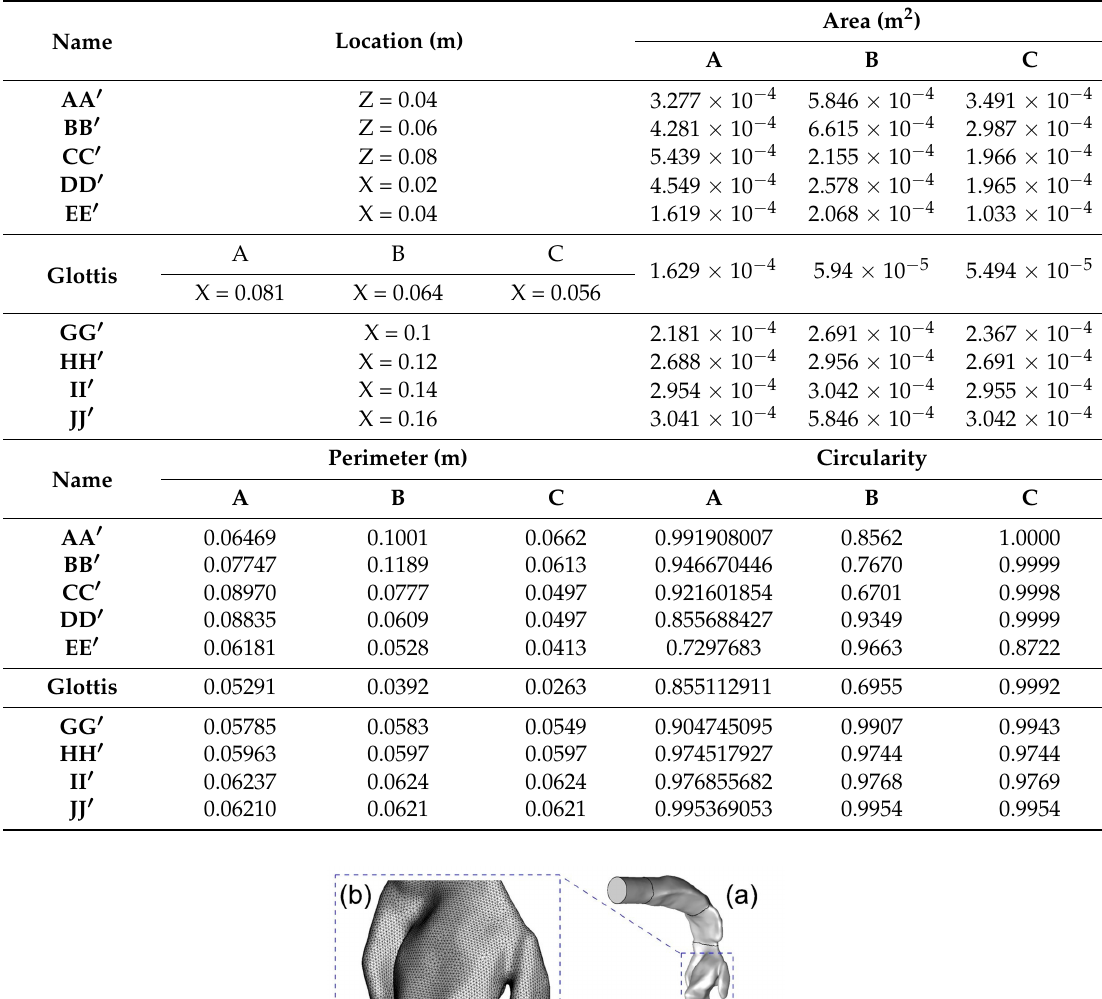
Table 1. Geometric parameters of cross-sections in the three geometries.